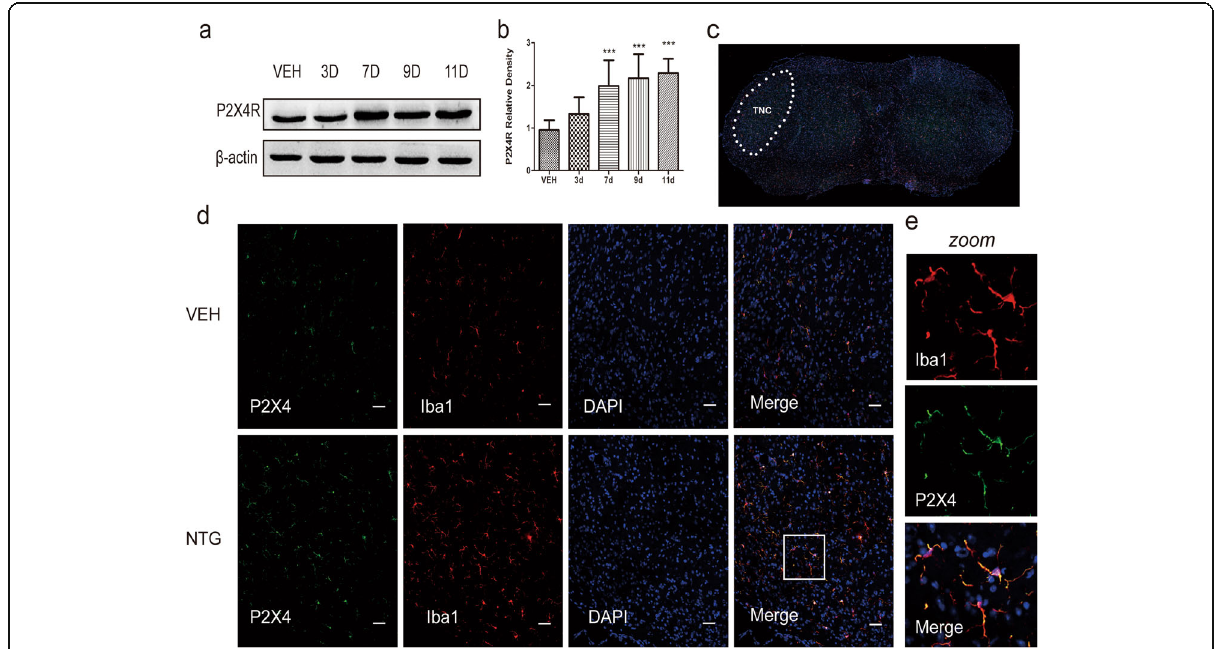
Fig. 2 Expression profile of the P2X4R in the TNC after the recurrent intermittent administration of NTG. a , b Western blot assay for the expression profile of P2X4Rs in VEH and NTG mice on days 3, 7, 9, and 11. One-way ANOVA and Tukey ’ s multiple comparison test. n = 6/group, *** p < 0.001 versus VEH. c The white dotted line frame indicates the TNC regions. d Representative photographs of immunofluorescence staining for P2X4R (green) expression in microglia (Iba-1, red) in the TNC in the VEH and NTG groups on day 11. Scale bar = 50 μ m. e The white box